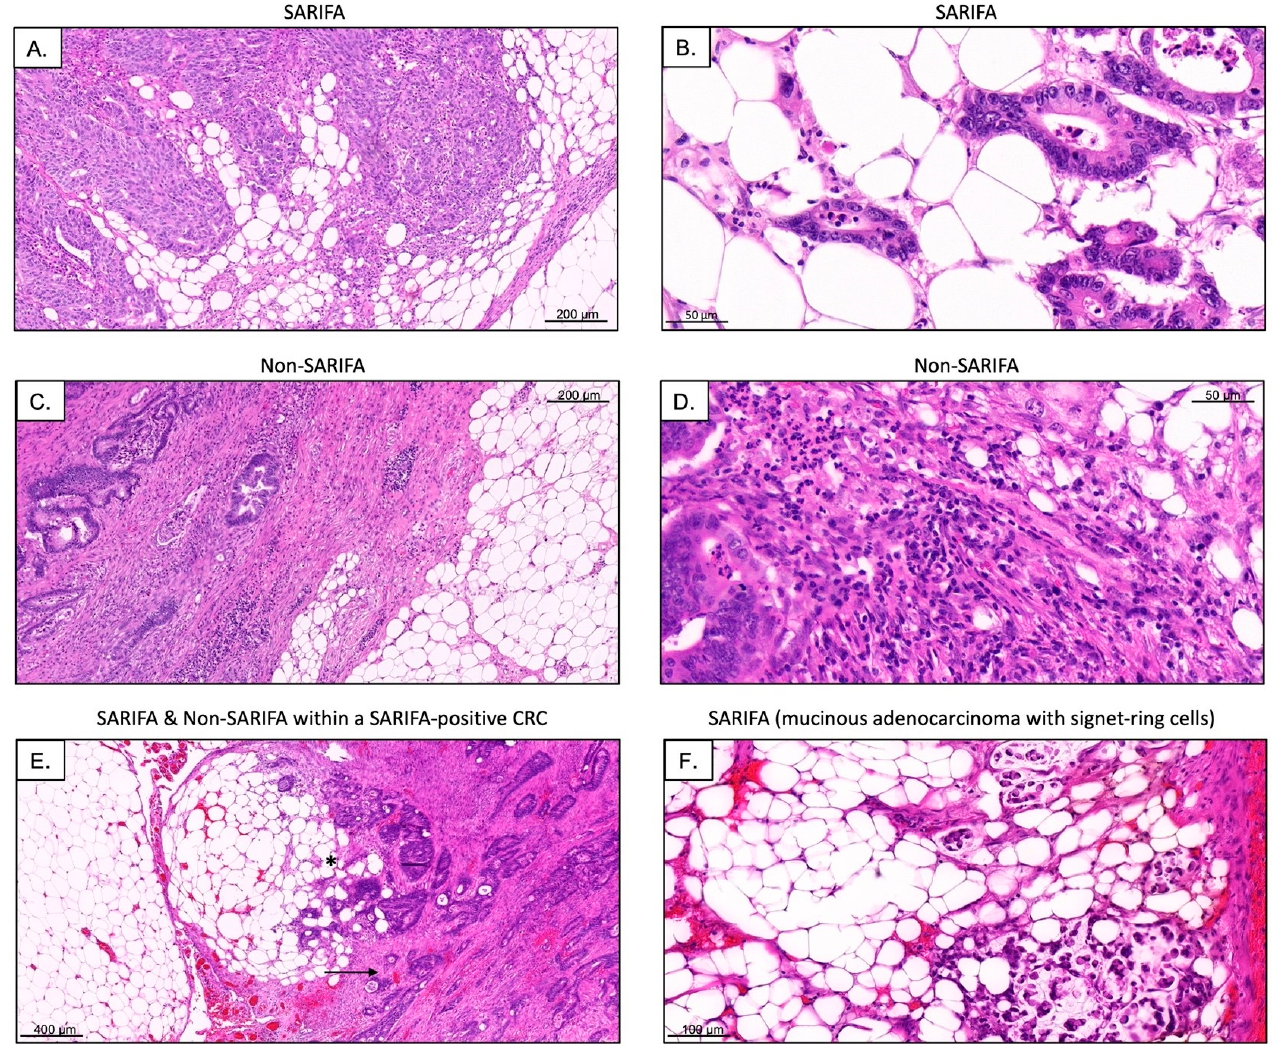
Figure 1. Representative H&E stains of SARIFAs as well as non-SARIFAs ( A and C ; scale bar = 200 µm; B and D ; scale bar = 50 µm). Even in SARIFA-positive CRCs (SARIFA marked by *) some parts of the invasive margin are non-SARIFA (marked by an arrow; E , scale bar = 400 µm). Additionally, rarer subtypes of CRC, such as mucinous adenocarcinoma with signet-ring cells, can show SARIFA ( F, scale bar = 100 µm).